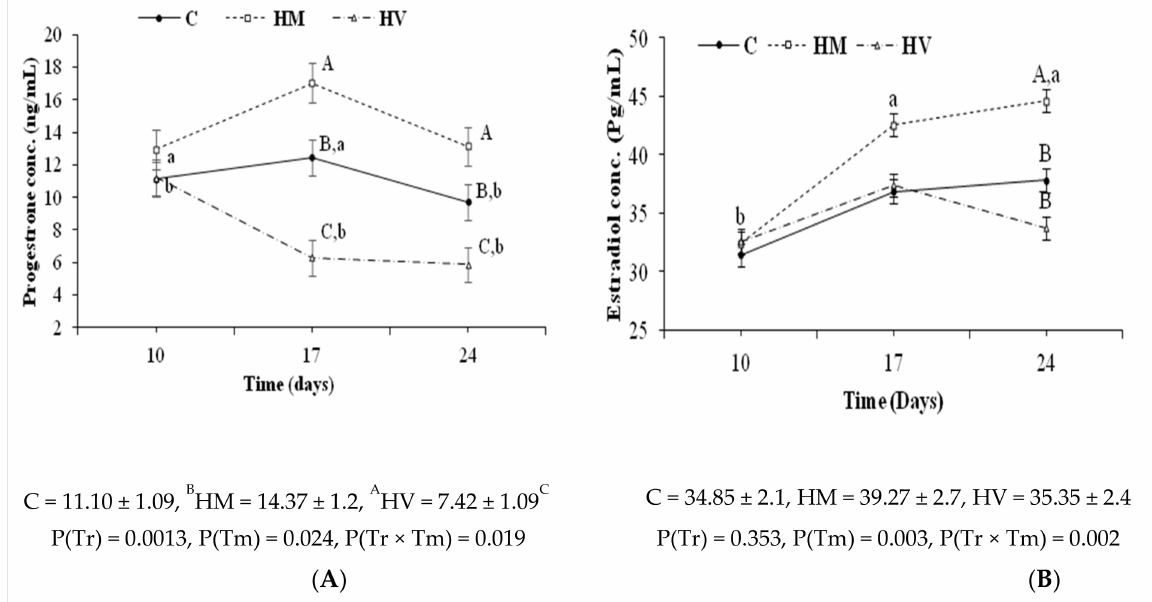
Figure 7. Changes over time in mean ( ± S.E.M.) serum progesterone ( A ) and E2 concentrations ( B ) in rabbit does receiving i.m. doses (HM = 0.4 µ g) or intravaginal doses (HV = 4 µ g) of GnRH–ChNPs or bare GnRH (C = 0.8 µ g). Overall values are included below the figure. P(Tr) accounts for treatment effects, P(Tm) for time effects, and P(Tr × Tm) for their interactions. Different uppercase and lowercase superscripts denote significant differences ( p < 0.05) between or within treatments,